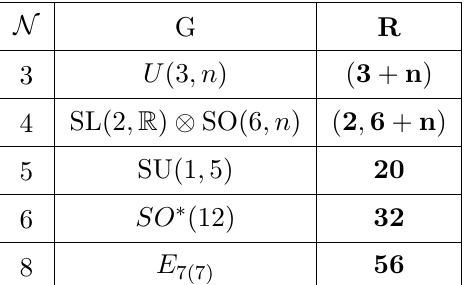
of the corresponding G symmetric spaces, and H G = 4 duality group is non-degenerate, N